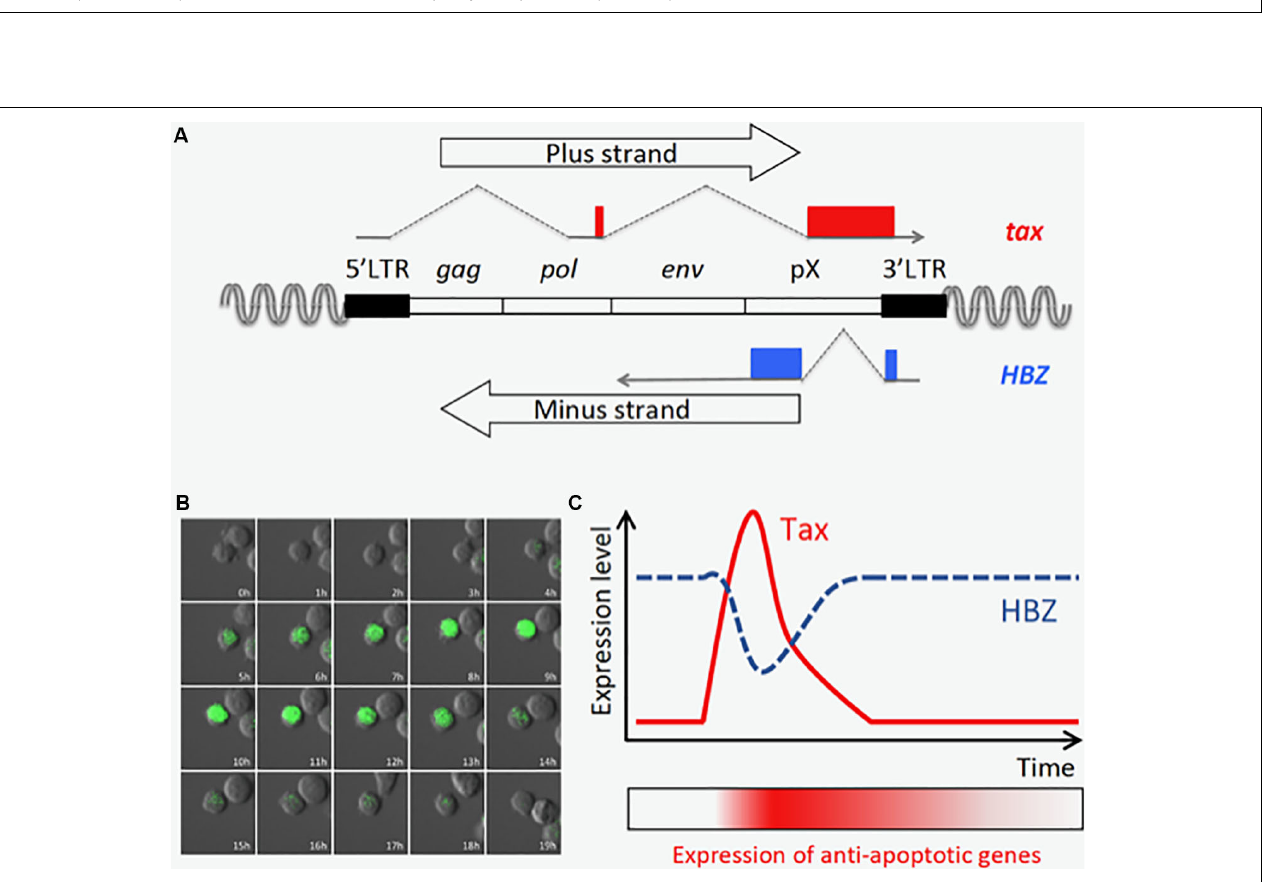
FIGURE 2 | Tax is transiently expressed in an ATL cell line, MT-1. (A) Structure of the provirus and the tax and HBZ genes. (B) Time-lapse imaging of Tax expression in MT-1 cells. Destabilized EGFP protein (d2EGFP) expressed under the control of Tax-responsive elements is used to visualize Tax expression. The image was modified from the one obtained in the author’s previous work (Mahgoub et al., 2018). (C) Tax is transiently expressed, and HBZ expression is oppositely regulated (Mahgoub et al., 2018). Prolonged induction of anti-apoptotic genes is observed even after Tax is diminished, and this may be important for maintenance of the MT-1 cell